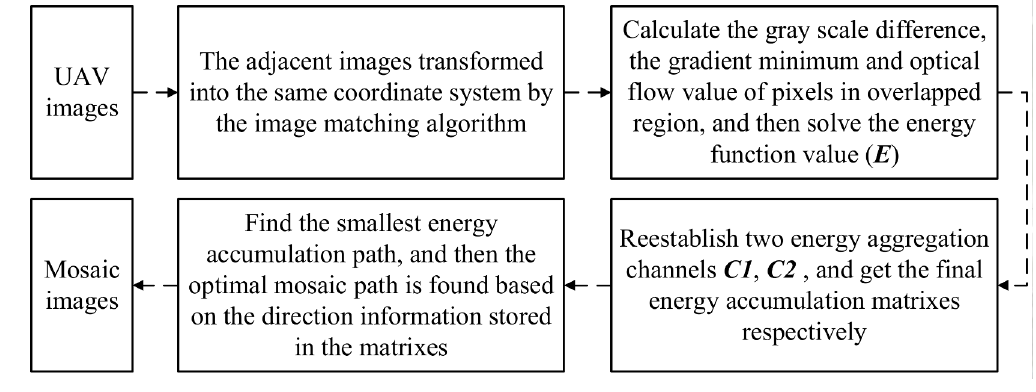
Figure 6. A flow chart of our